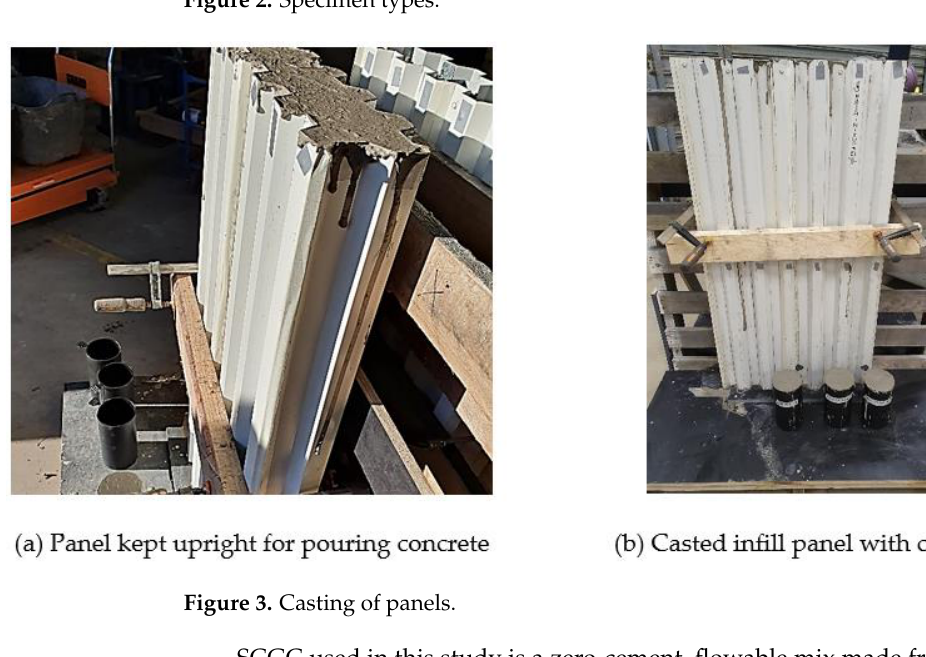
Figure 2. Specimen types.